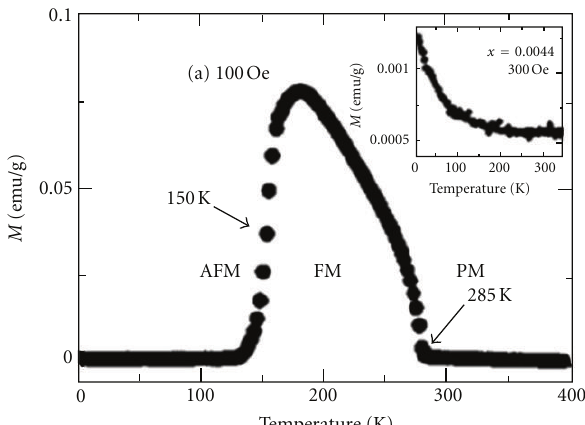
Figure 5: Magnetization versus temperature curve of Mn 0 . 04 Ge 0 . 96 in a 100-Oe magnetic field. The inset shows paramagnetic ordering for Ge 1 − x Mn x with x = 0 . 0044. Reproduced from [5]. Copyright ©2002, The American Physical Society.